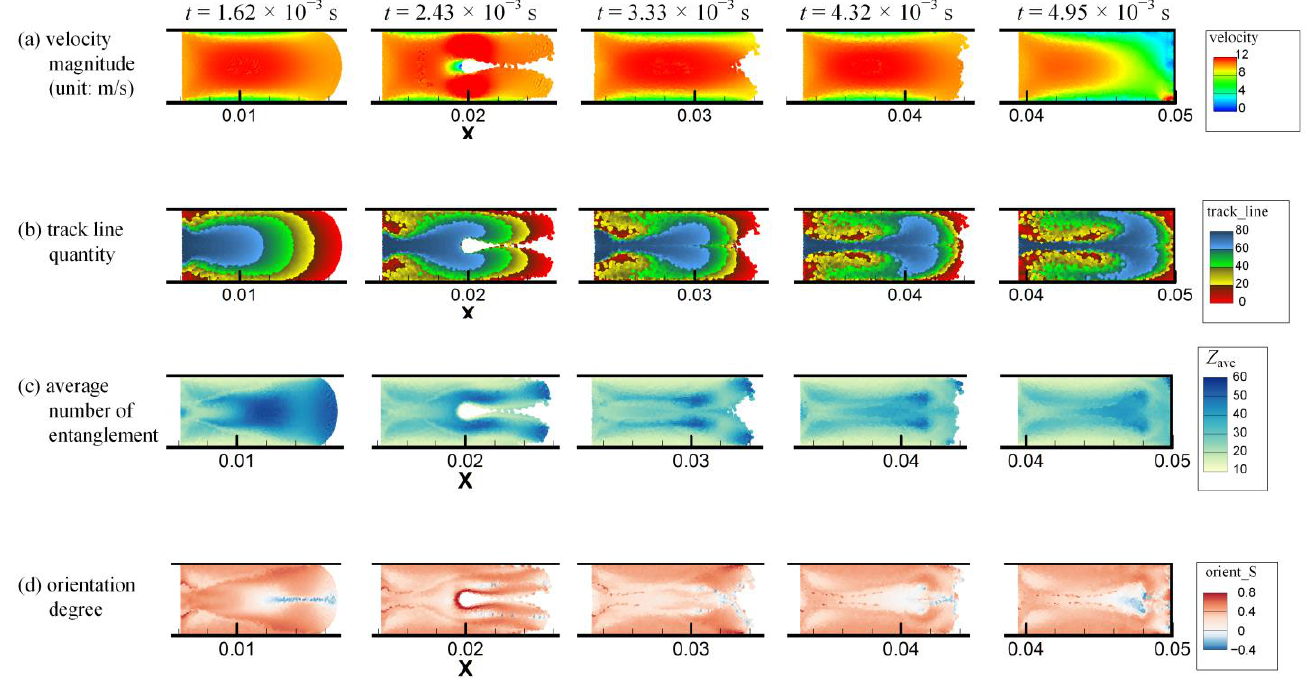
Figure 9. The multiscale simulation results of ( a ) velocity magnitude, ( b ) track line quantity, ( c ) average number of entanglements and ( d ) orientation degree distributions of injection molding in the rectangular cavity with circular obstacle at different times as indicated.